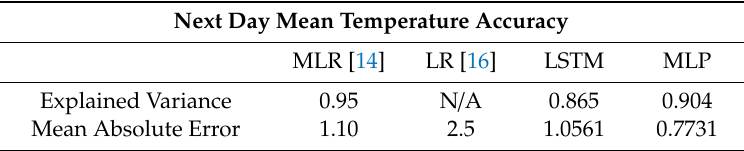
Table 12. Comparison table of the next day’s mean temperature (unit: ◦